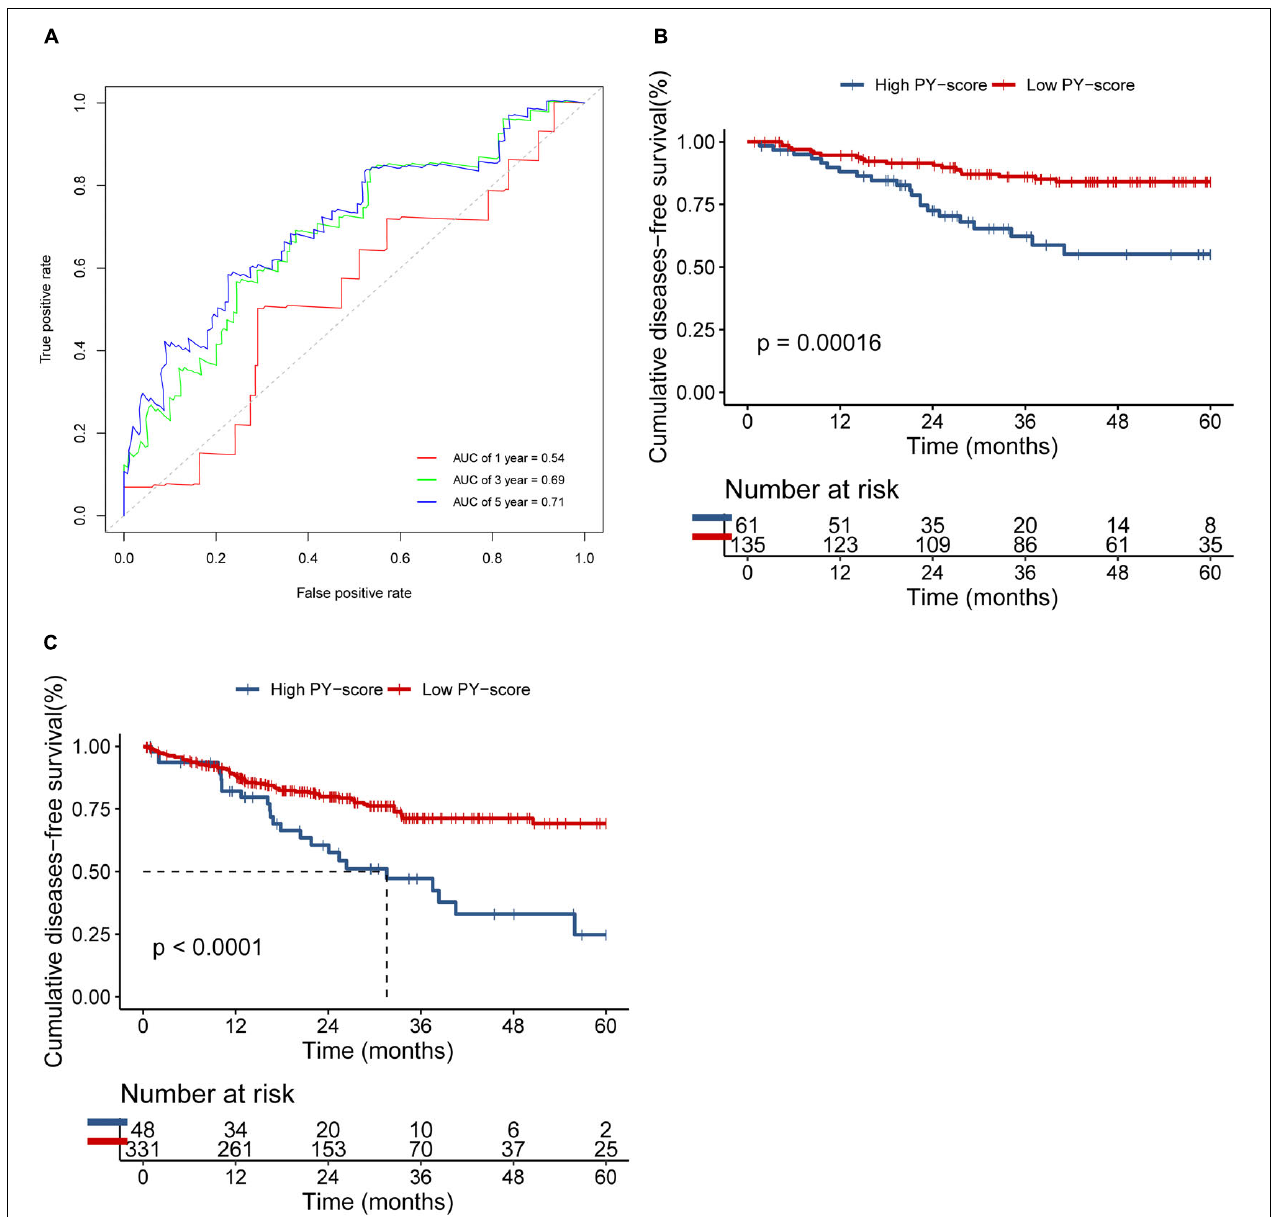
FIGURE 6 | Validation of the role of the pyroptosis score (PY-score) in predicting the survival of colon cancer patients through the GSE14333 and TCGA-COAD cohorts. (A) Predictive value of the PY-score in colon cancer patients from the GSE14333 cohort. (B,C) Survival analyses for patients from the low (135 cases) and high (61 cases) PY-score groups in the GSE14333 cohort ( p < 0.001) and for patients from the low (331 cases) and high (48 cases) PY-score groups in TCGA-COAD cohort ( p < 0.001) (C) using Kaplan–Meier